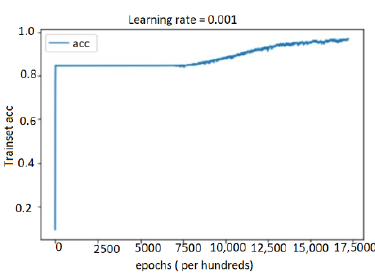
Figure 11. Training accuracy versus epochs for audio modality.